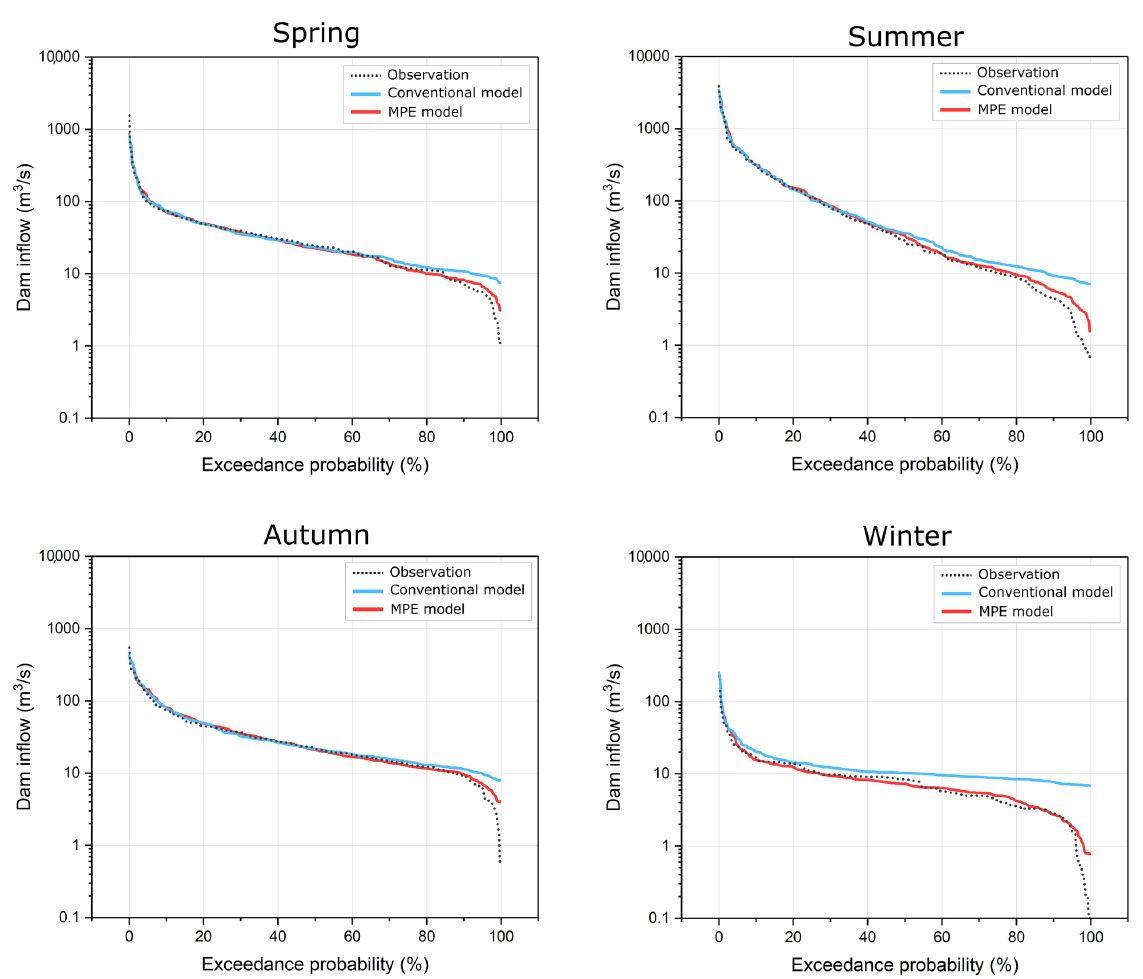
Figure 9. FDCs of predicted and observed seasonal in fl